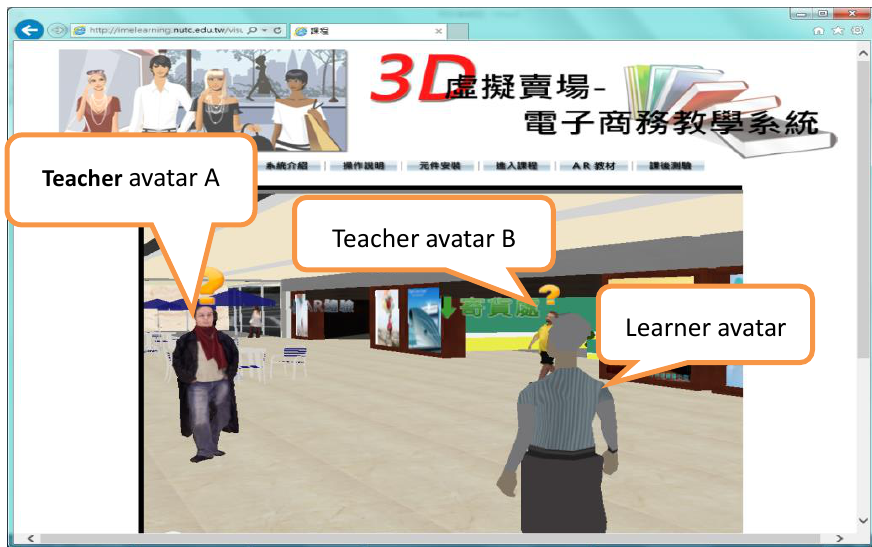
Figure 3. ECVRLS system architecture.